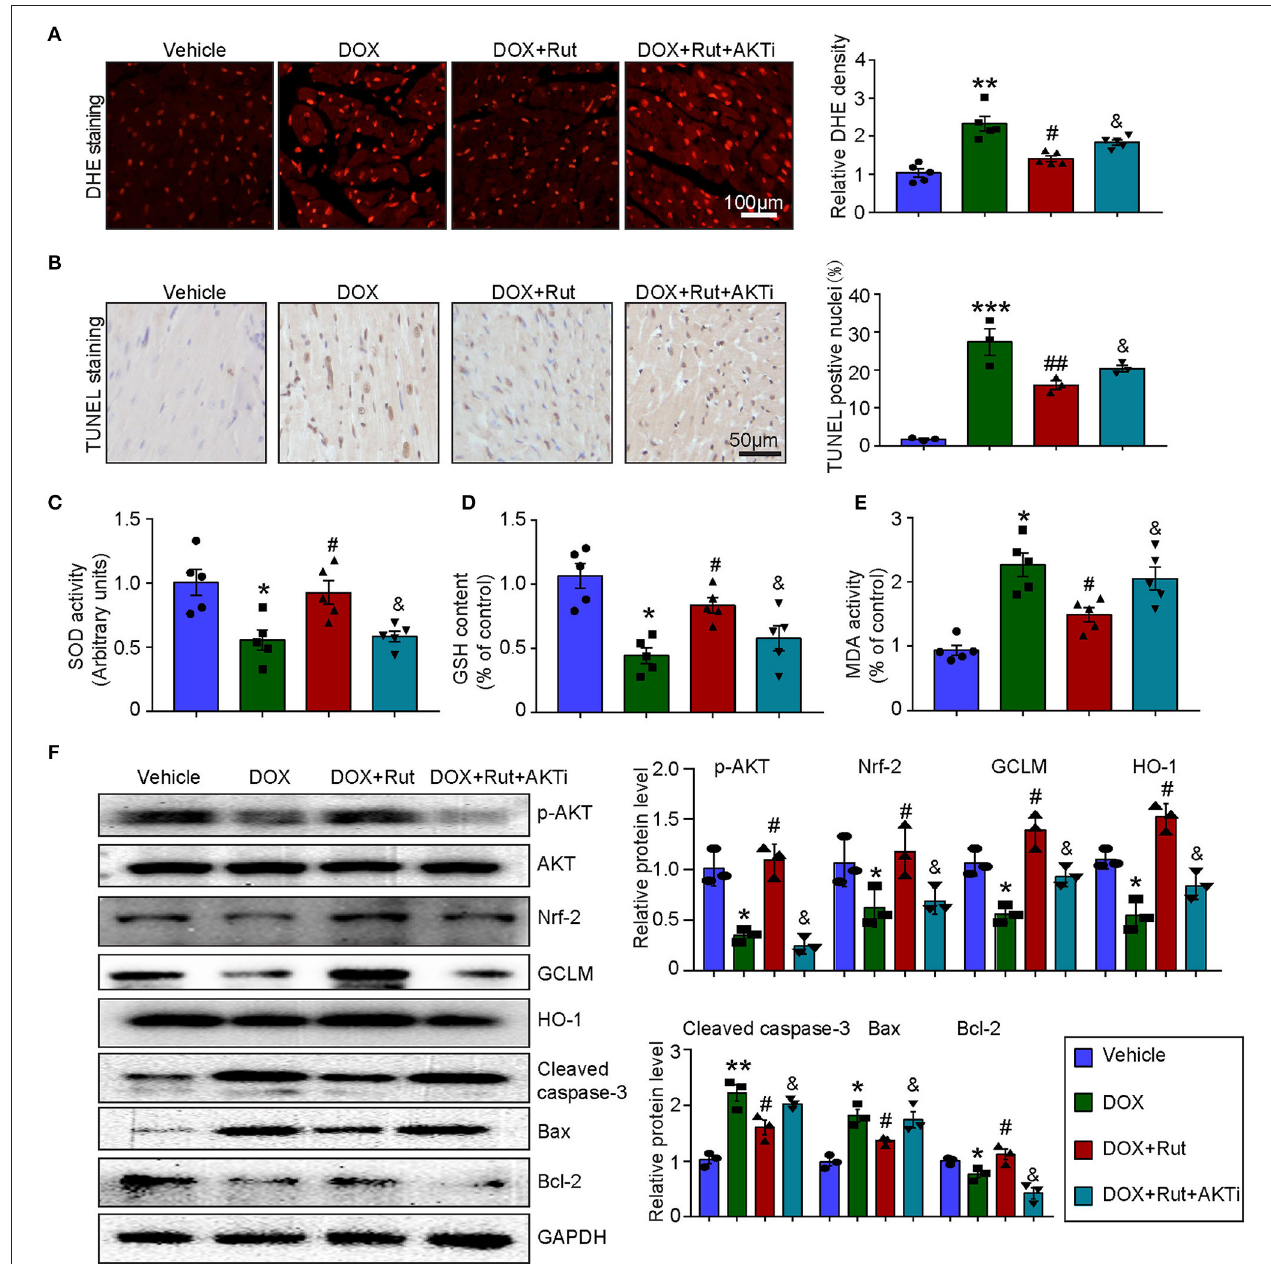
FIGURE 5 | AKT inhibitor (AKTi) abolished the antioxidant and antiapoptotic effect of rutaecarpine in DOX-treated hearts. Mice were intraperitoneally injected with AKTi (20 mg/kg) every other day for 4 weeks before DOX and Rut administration. (A) ROS generation in the heart was detected by DHE staining, and the quantification of fluorescence intensity was shown right ( n = 5). Scale bar 100 µ m. (B) Representative TUNEL staining in the heart tissues and the TUNEL-positive nuclei were quantified ( n = 3, right). Scale bar 50 µ m. (C–E) Relative SOD activity, GSH content, and MDA activity in the heart; data in other groups were normalized to the vehicle group ( n = 5). (F) Western blot analysis of p-AKT, Nrf-2, GCLM, HO-1, cleaved caspase-3, Bax, and Bcl-2 in the heart, and the relevant quantification was shown right ( n = 3). * p < 0.05, ** p < 0.01, *** p < 0.001 vs. vehicle; # p < 0.05, ## p < 0.01 vs. DOX group; & p < 0.05 vs. DOX plus Rut group.